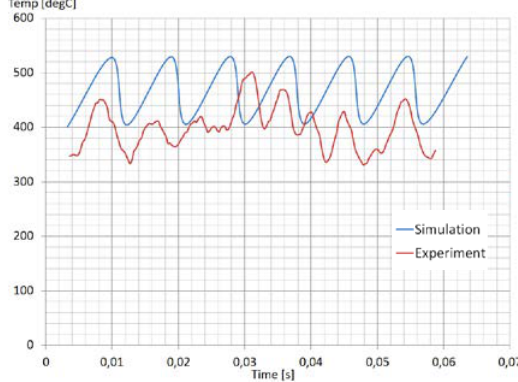
Fig. 11. Comparison of simulated and real instantaneous temperature sensor behavior